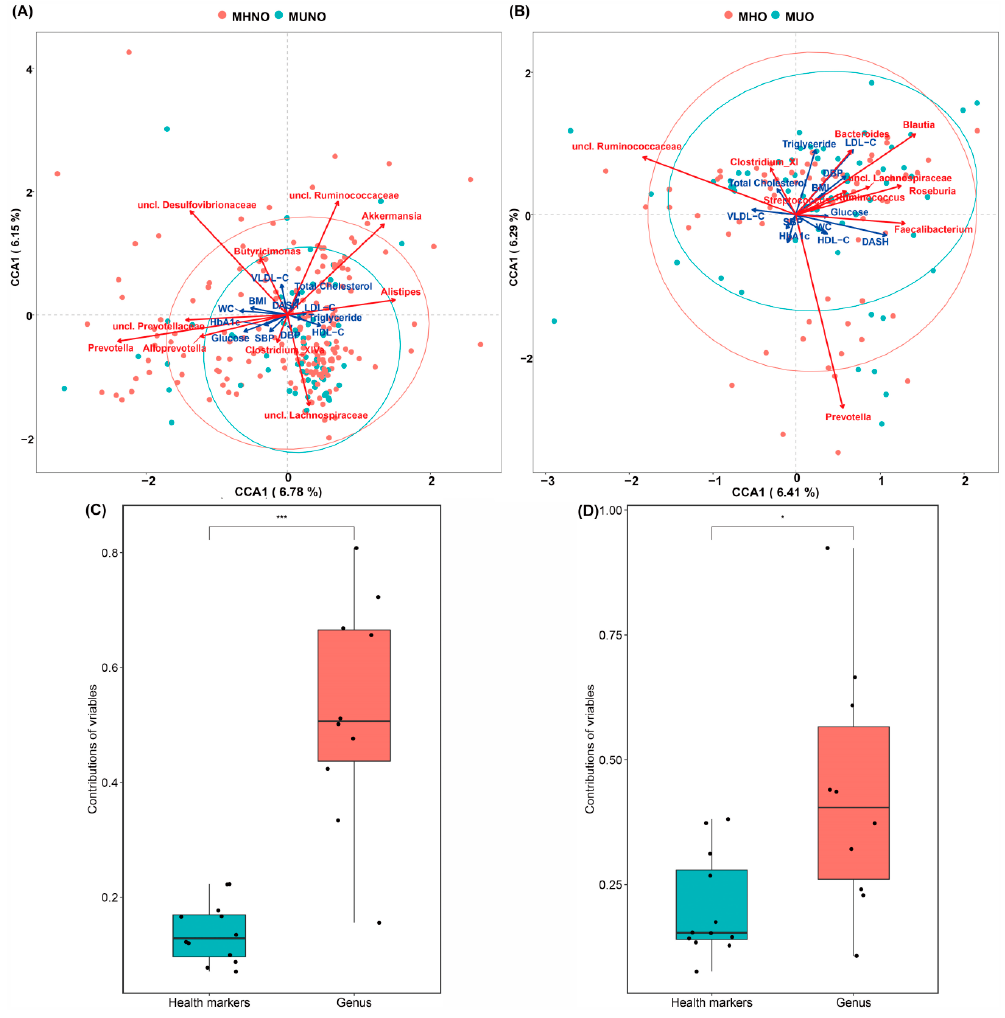
Figure 2. Microbial community variation in the MCR cohort. ( A ) MHNO vs MUNO, ( B ) MHO vs MUO, ( C ) the contribution of variables to the variance of MHNO and MUNO bacterial community, ( D ) the contribution of variables to the variance of MHO and MUO bacterial community. Top contributors of genus to the community variation as determined by redundancy analysis on scaled OTUs abundances (red arrows); metabolic health markers contribute to microbiome community variation (blue arrows). Arrows scaled to contribution. * p < 0.05, *** p < 0.001. In terms of the co-variation of metabolic health markers with the microbiota variation, vectoral differences of HbA 1c , glucose, BMI, WC, and SBP values showed a similar direction of association with Prevotella genus, while HDL-C and triglyceride formed a directional trend with Alistipes in MHNO and MUNO groups. For MHO and MUO groups, vectors of LDL − C, triglycerides, DBP and BMI value gradients showed a similar direction of association to Bacteroides and Blautia ; glucose, WC, HDL-C coincided with genus Faecalibacterium ; HbA 1c and SBP formed acute vector with Prevotella . However, among the associations we detected, the contribution of the individual metabolic health markers was significantly lower than those of the genus factors (Figure 2C,D). 3.4. Fine-detail taxonomic composition of gut microbiota We further interrogated the composition of gut microbiota at different taxonomic levels (Figure S3 and Figure S4). Sequences were sorted into 6527 OTUs ( ≥ 97% identity). Of these OTUs, 490 were